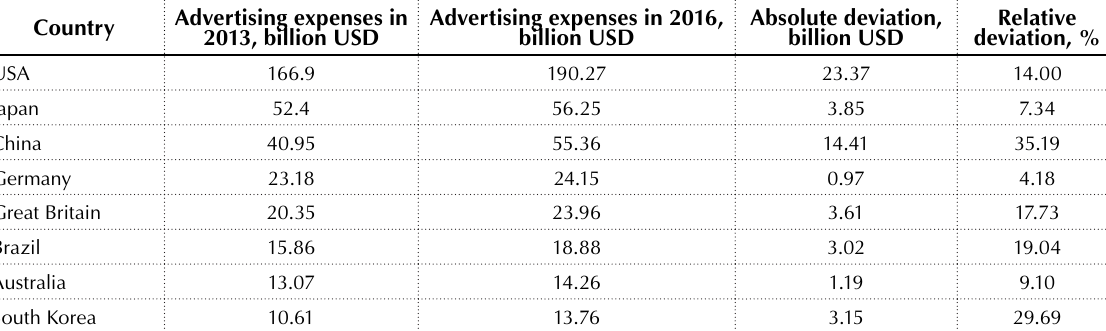
Table 1. The comparative structure of the world advertising market in 2013 and